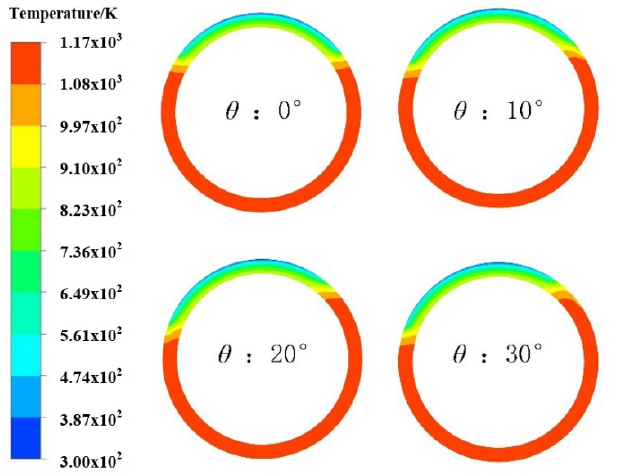
Figure 8. Temperature distribution in the thickness direction of steel tube.